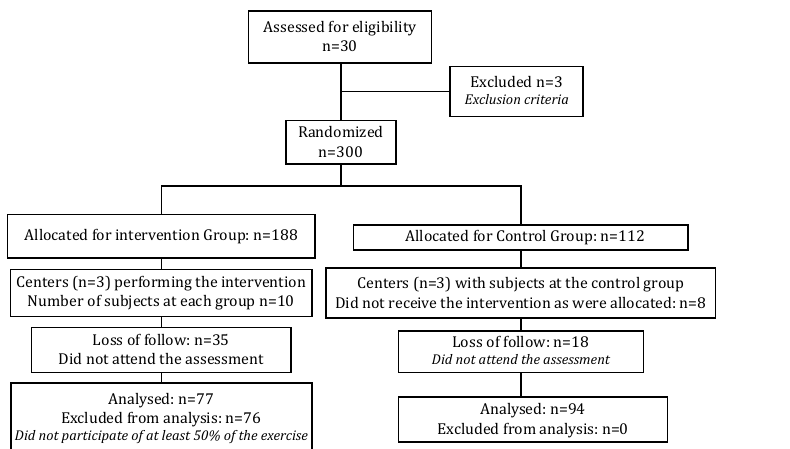
Figure 1 – Flowchart of participants during the study